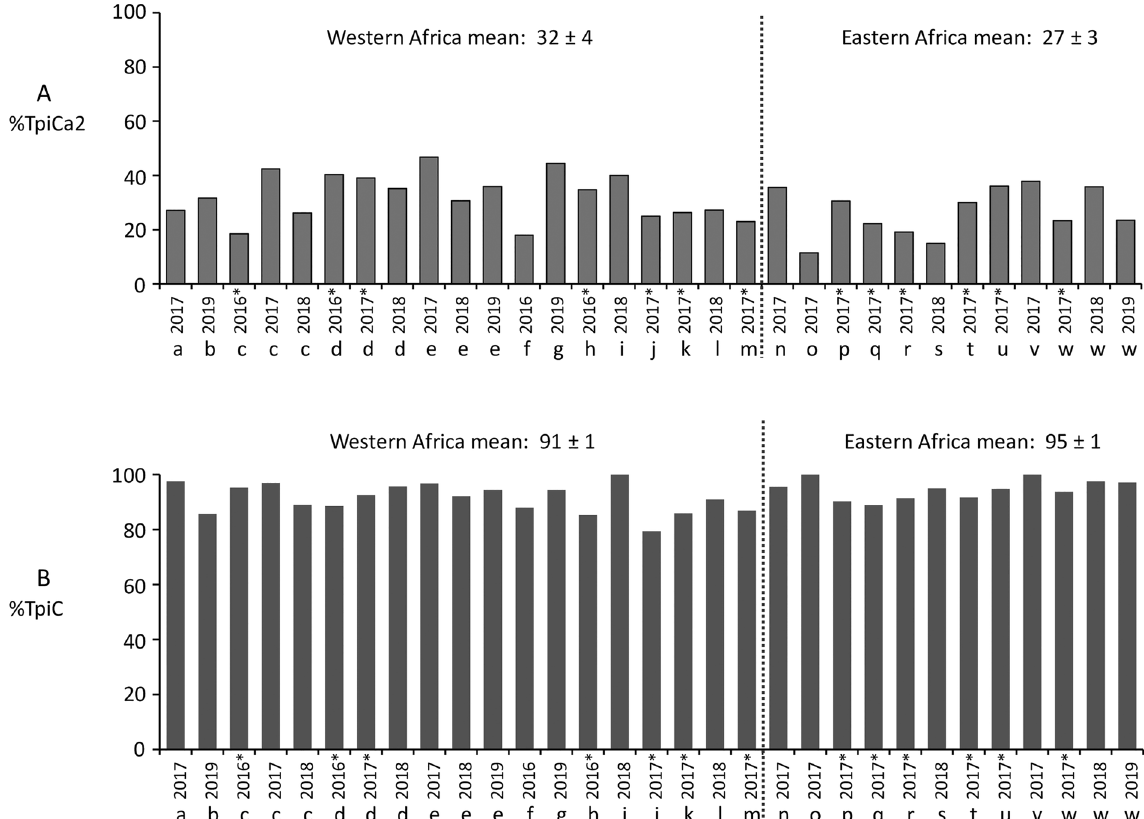
Figure 4. Bar graphs indicating frequency of Tpi haplotypes in western and eastern Africa. Collections are as described in Table 1. The mean ± SEM for different regions is presented above the graph. Asterisks indicate data from earlier studies. ( A ) Frequency of the TpiCa2 haplotype. ( B ) Frequency of the TpiC haplotype diagnostic of the The mean TpiH frequency was higher in western Africa (13%) than eastern (8%), but the difference was not statistically significant (Table 2m). The TpiH specimens were found in all countries except for Ethiopia, Gabon,